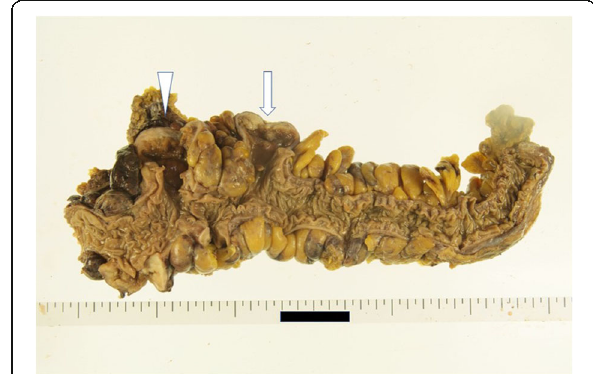
Fig. 4 The specimen of the sigmoid colon revealed the proximal lesion (arrow) and the distal lesion (arrowhead). They were within the